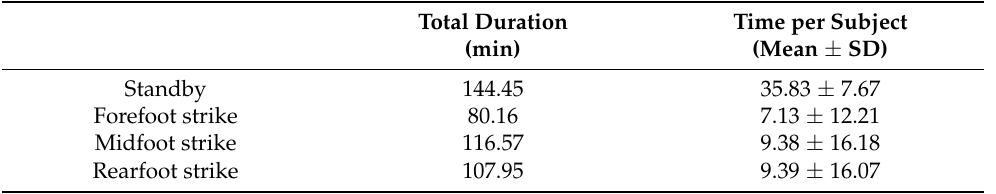
Table 1. Data acquired while walking with different strategies.